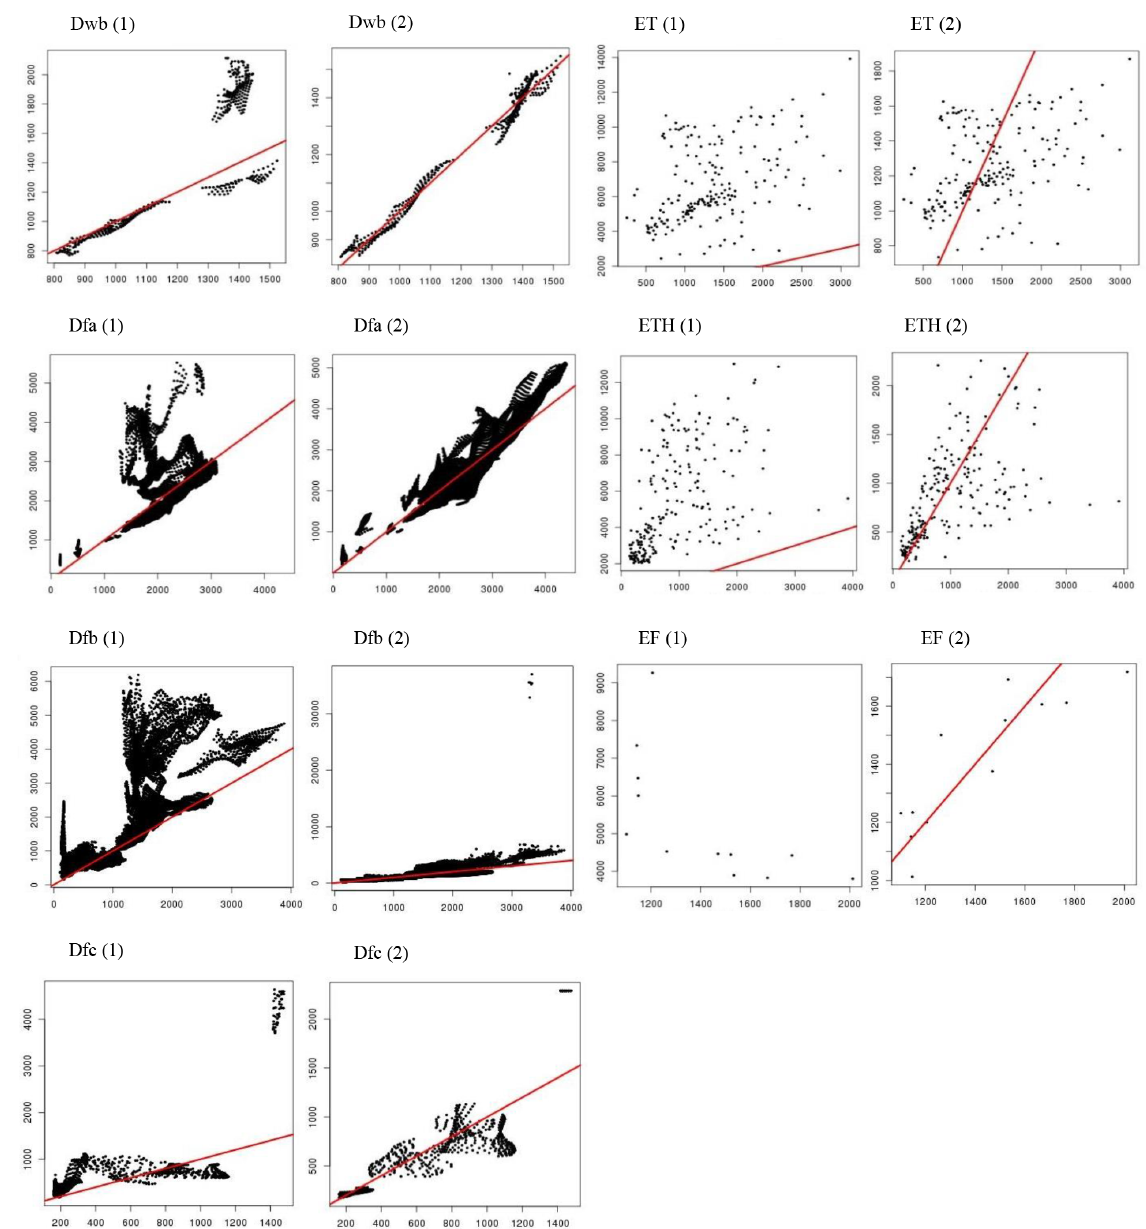
Figure 5. Comparison of high resolution R factor data and predicted R values from (1) the Renard and Freimund (1994) method and (2) the new regression equations, for various climate zones; the red line is the 1-to-1 line and does not appear in some graphs because predicted R values are